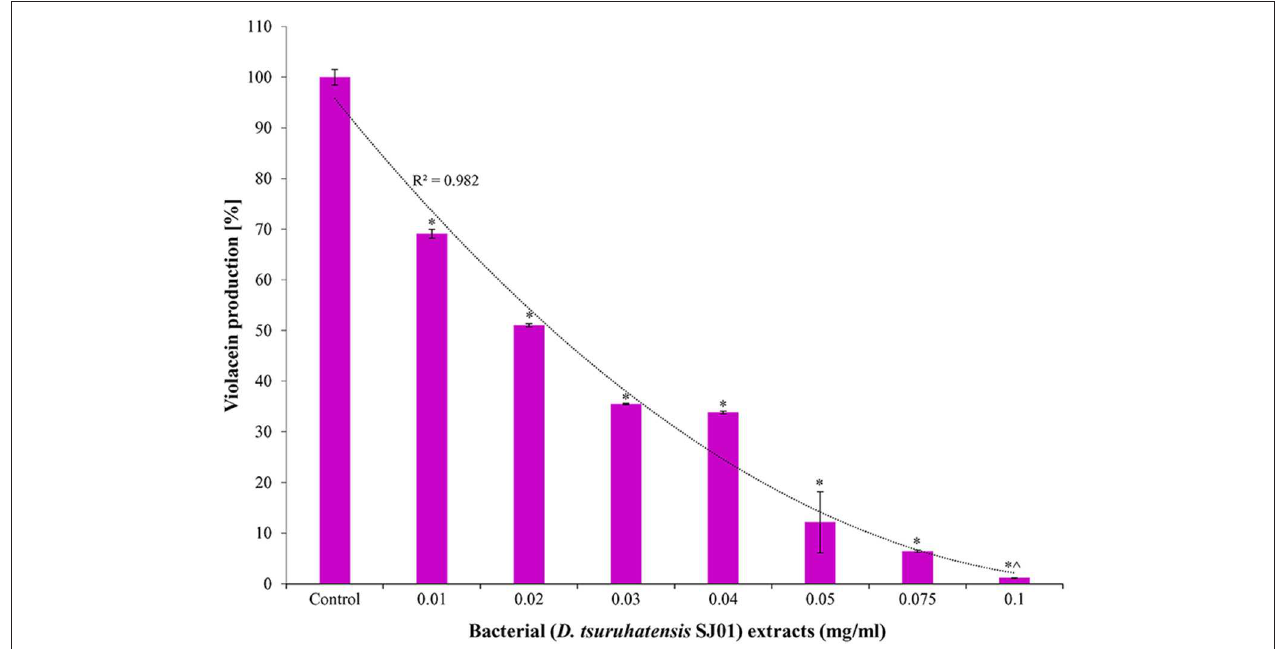
FIGURE 2 | Effect of different concentration of D. tsuruhatensis SJ01 extract on violacein production. Different concentration of bacterial extract (0.01 − 0.1 mg/ml) was used to quantify the inhibition of violacein, an indicator of quorum sensing activity. Cultures without extract were considered as a control. *Indicates significant differences from the control at P < 0.05 and ∧ indicates maximum significant differences from the control at P < 0.05 .